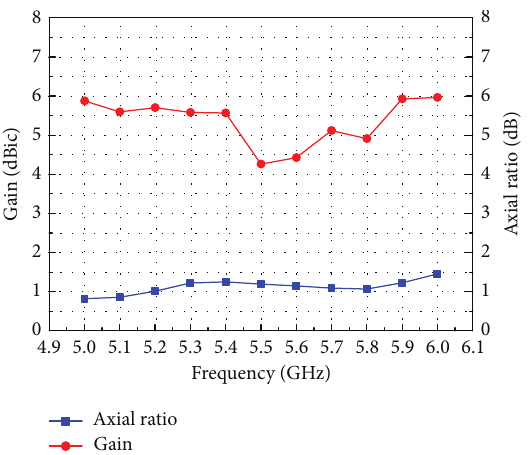
Figure 7: Measured gain and average axial ratio in the omnidirec- tional plane.